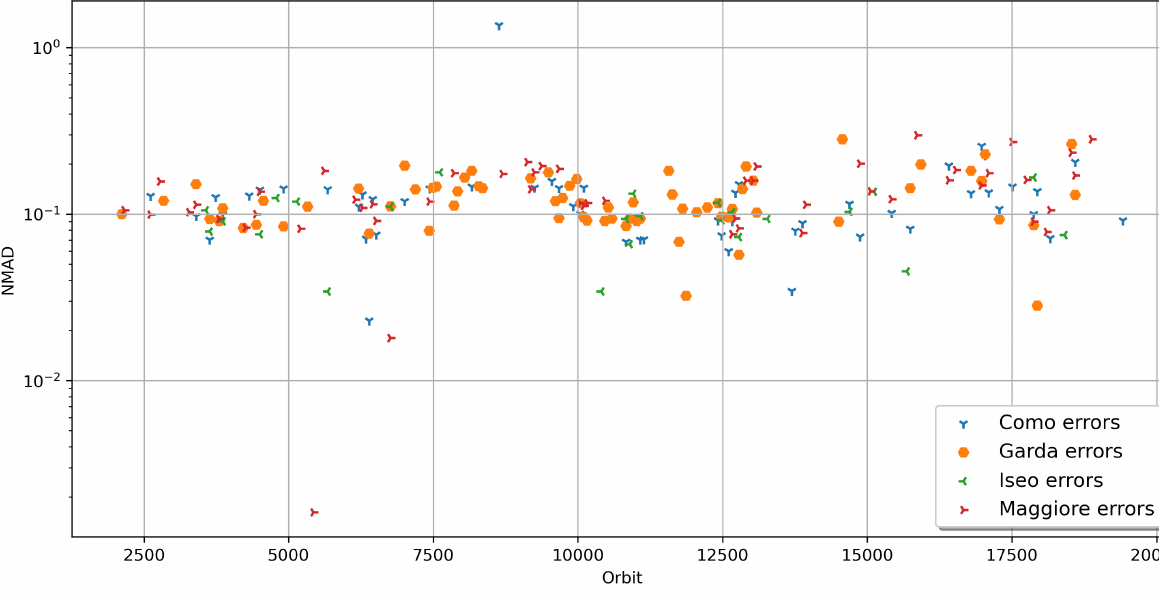
Figure 5. Scatter plot for NMAD (Error) of each epoch/orbit of each of the four lakes based on ISS orbits for the whole period